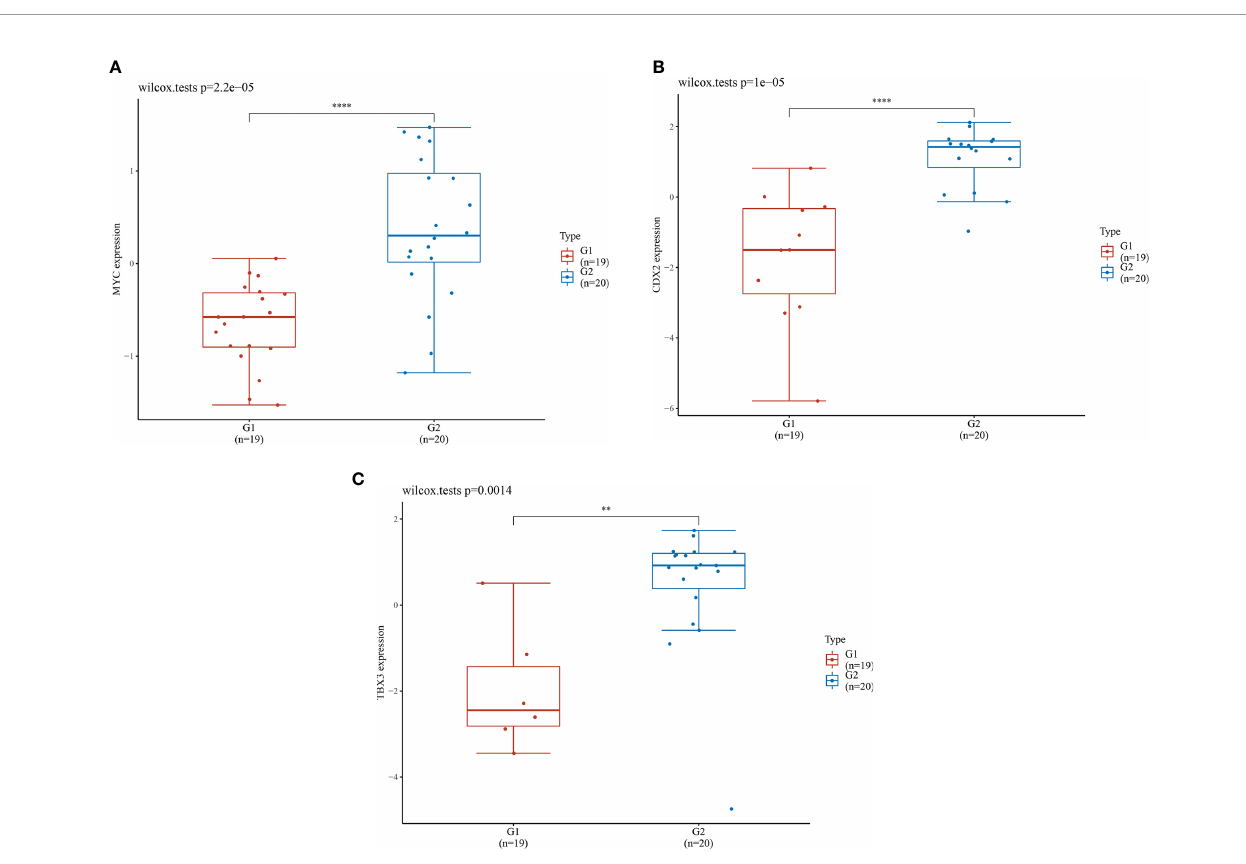
FIGURE 6 | Expression levels of 3 genes in different groups. G1 represents the in fl ammation group (n=19), G2 represents the HGIN group (n=20). The horizontal axis represents samples in different groups and the vertical axis represents the gene expression distribution. Different colors represent different groups. The left upper corner represents the signi fi cance p-value test method. (A) Expression distribution of MYC gene in different tissues; (B) Expression distribution of CDX2 gene in different tissues; (C) Expression distribution of TBX3 gene in different tissues. (**P < 0.01,****P <